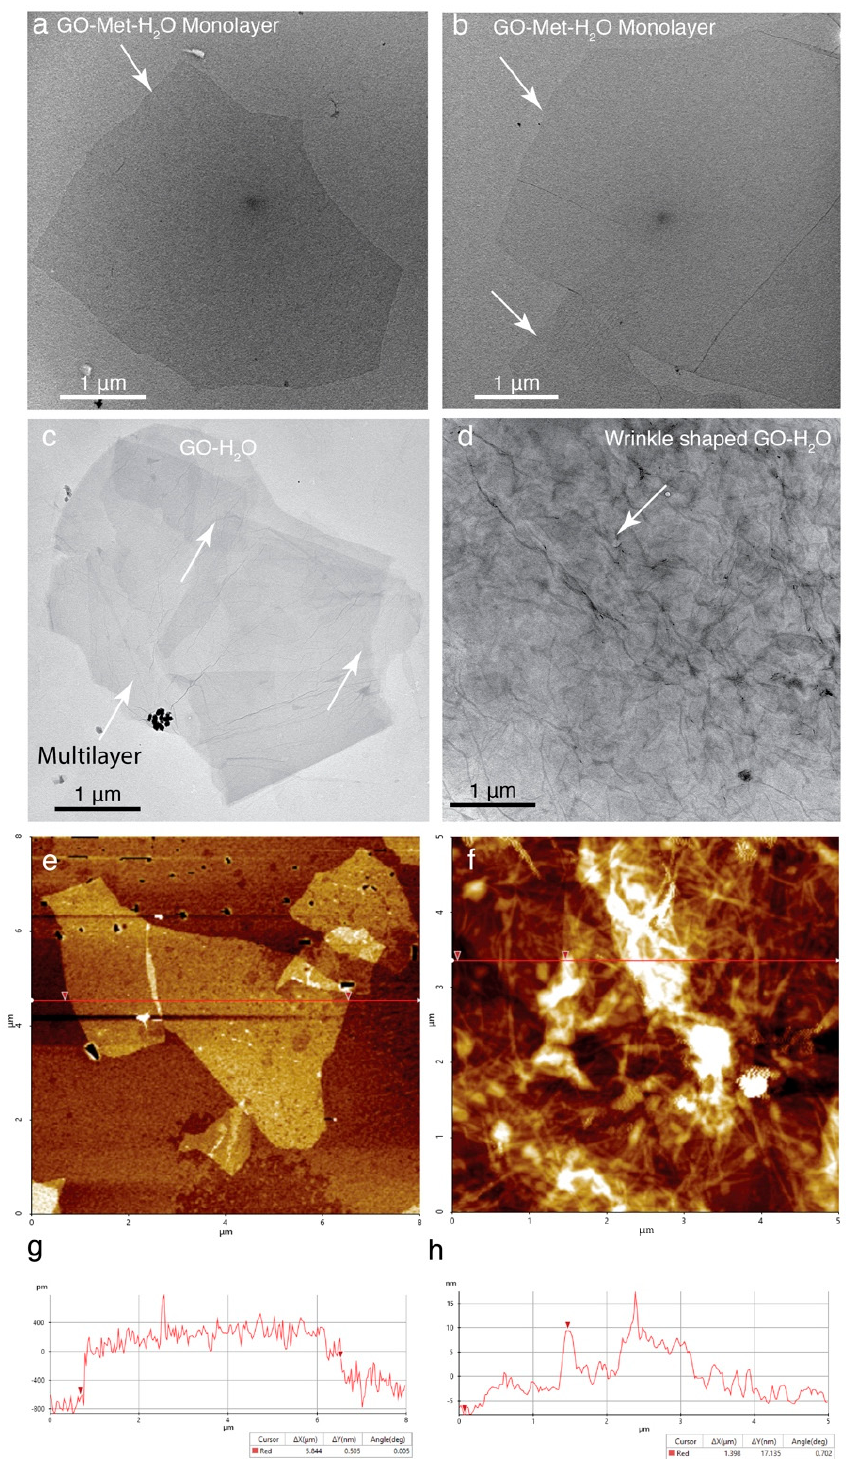
Figure 2. High resolution TEM and AFM studies to elucidate the GO surface properties: ( a , b ) High resolution TEM images of GO methanol-water where white arrows point the large monolayers. ( c , d ) High resolution TEM images of GO water where white arrows point sporadically distributed and wrinkled multilayers. ( e , g ) High resolution AFM image of GO methanol-water monolayer. ( f , h ) High resolution AFM image showing the GO water forms multilayer and aggregates.